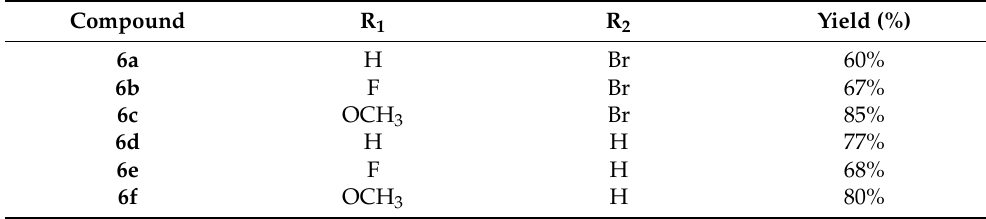
Table 1. Yields of the synthesis of 6a–f ; (1-Methyl-1 H -pyrrolo[2,3- b ]pyridin-3-yl)-[3-(1-methyl-1 H -